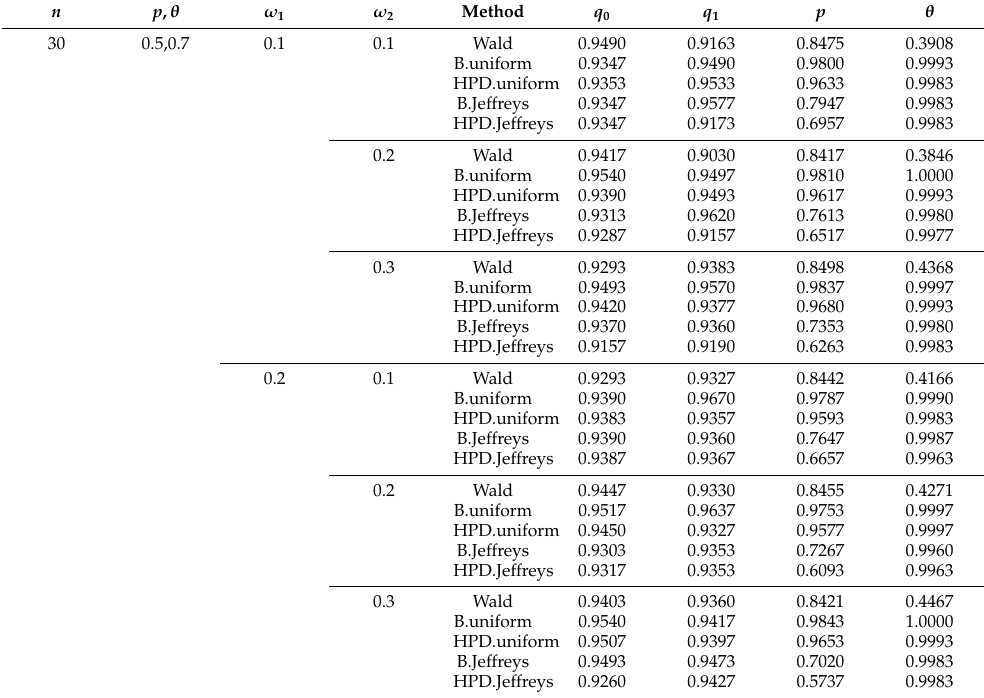
Table 1. Coverage probability of parameter estimation for model in Equation